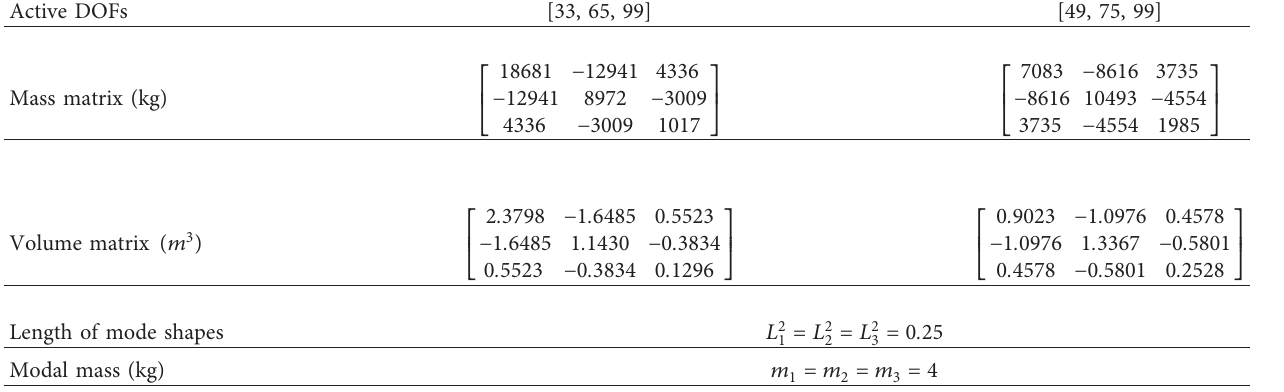
Table 2: Results obtained with a reduced model using SEREP [45].